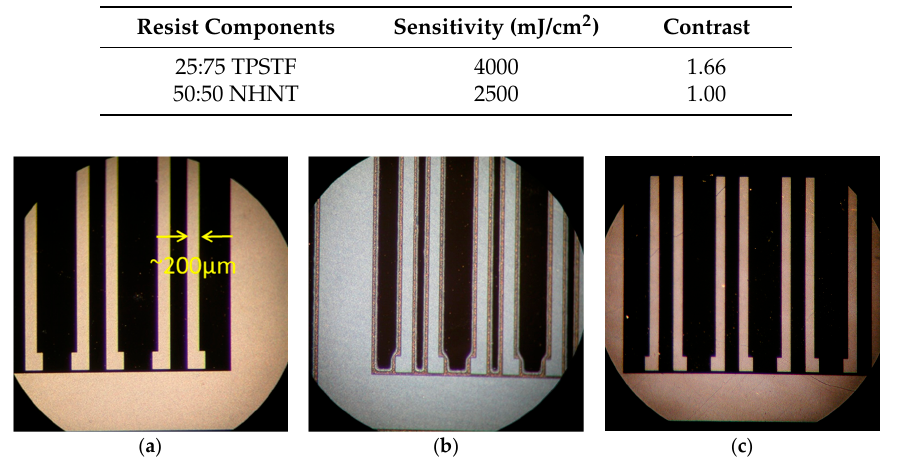
Figure 4. Mo 8 blend contrast curves using UV exposure (365–412 nm). Table 1. Contrast and sensitivity data for UV mask aligner exposures.